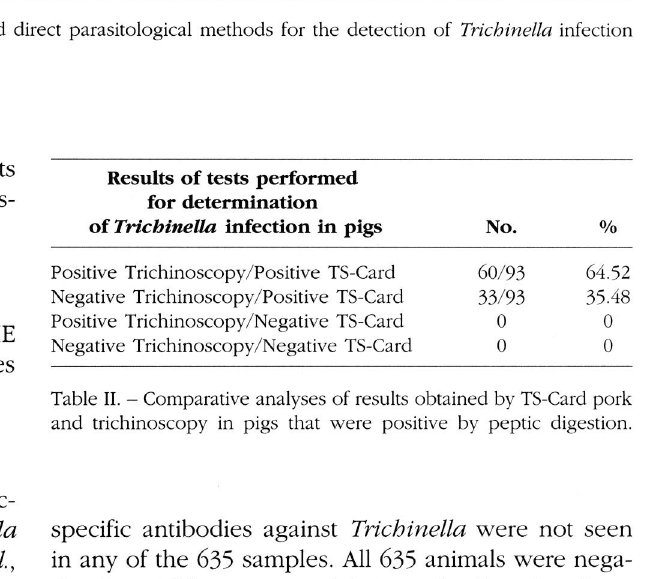
Table I. - Comparative efficacy of serological (TS-Card pork) and direct parasitological methods for the detection of Trichinetta infection in pigs in Romania.